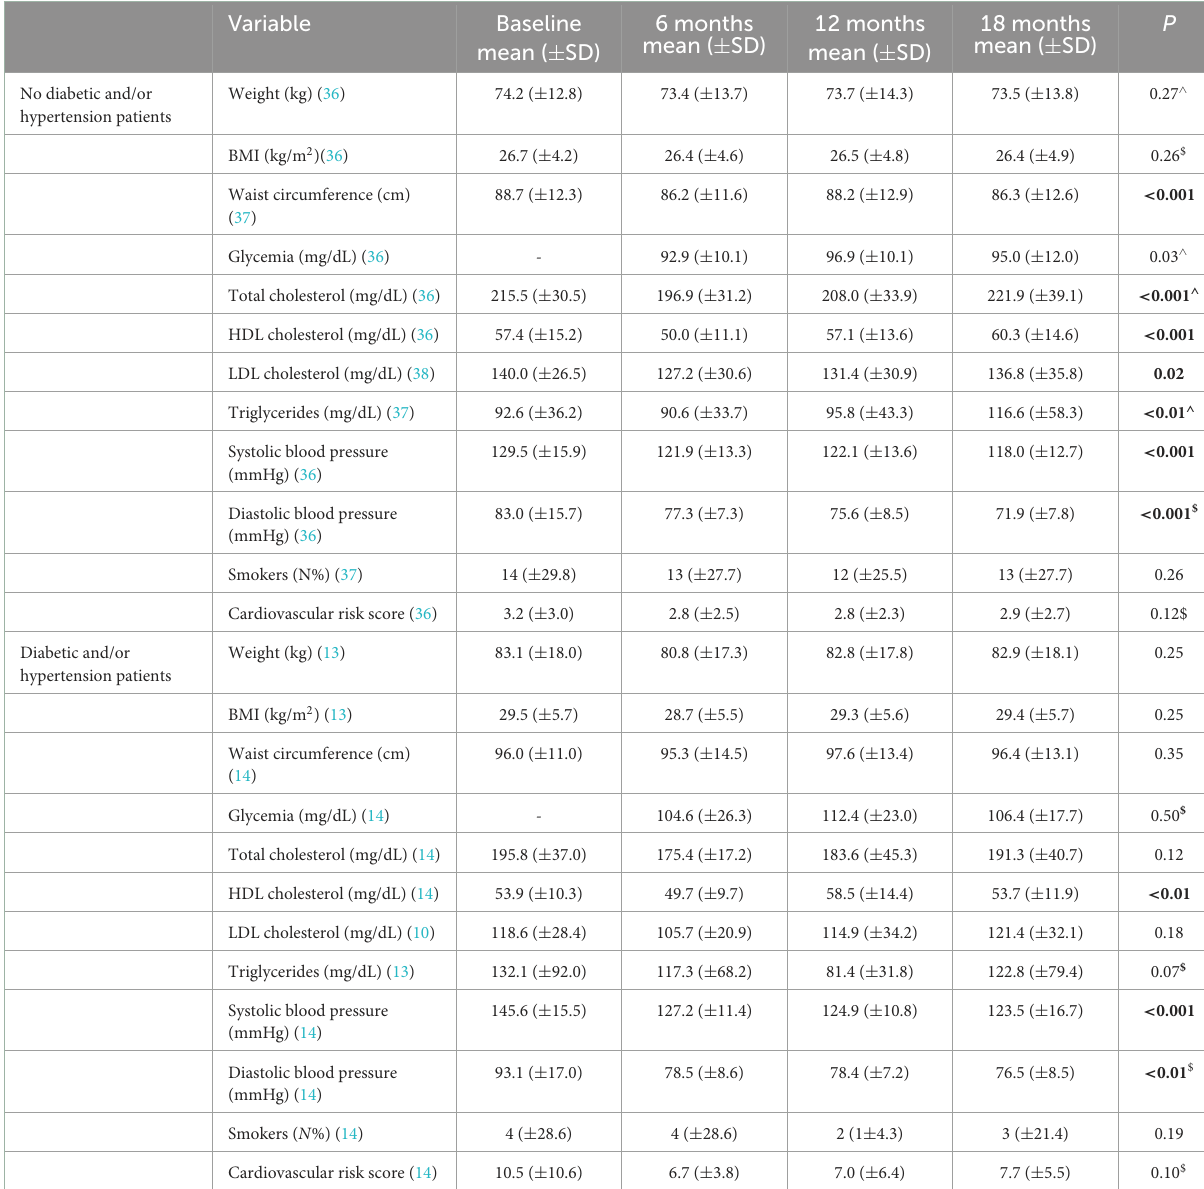
TABLE 3 Results of repeated measures ANOVA, stratified according to the presence of diabetes and/or